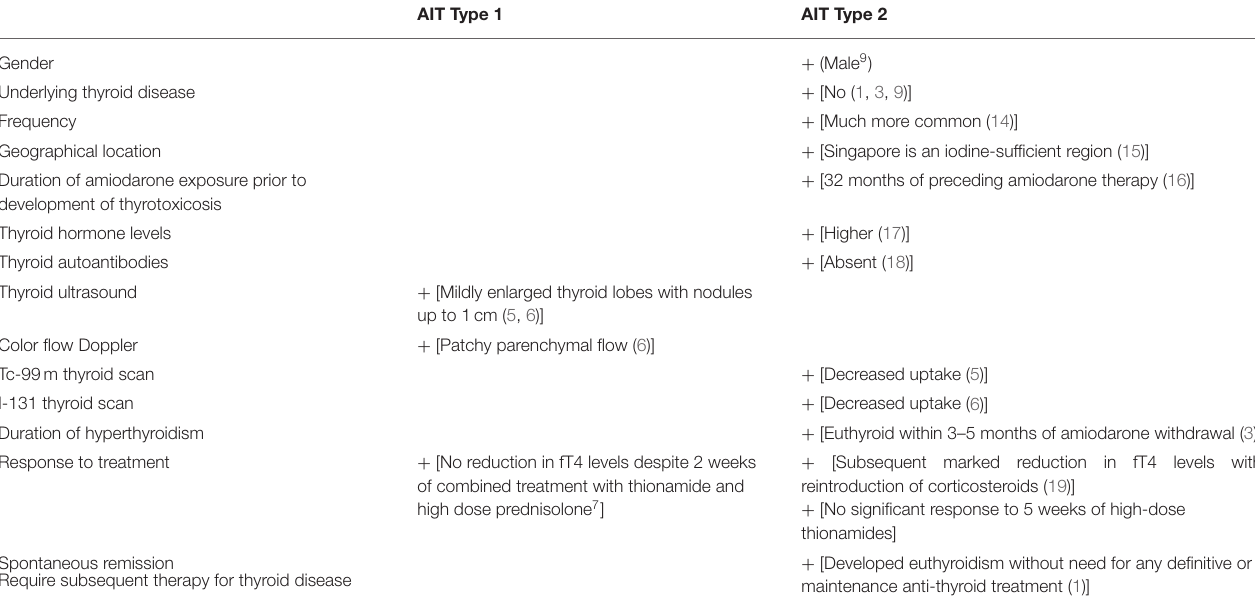
TABLE 3 | Features of AIT Type 1 and 2 in our